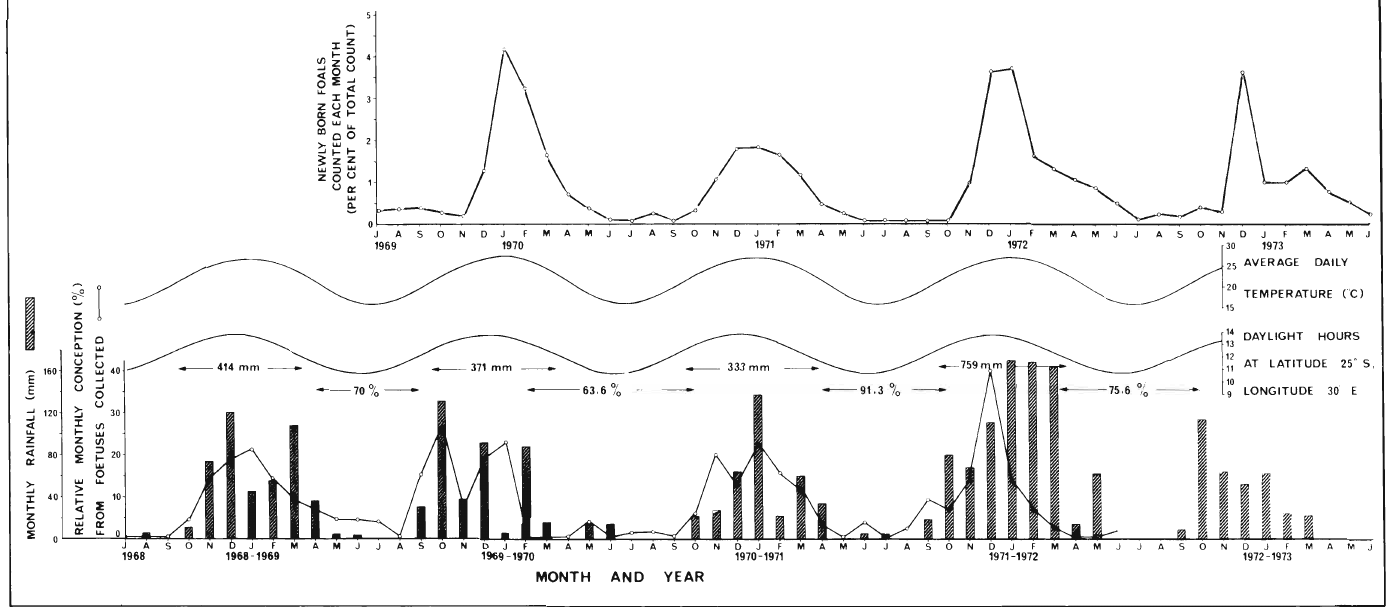
Fig. 6. The foaling season (upper graph) and mating season (lower graph) for zebra from the Central District of the Kruger National Park. Rainfall histograms as well as curves for average monthly daylight hours and average daily temperature are also included in the figure. Total summer precipitation (October to March) and conception rates for mares shot during the winter months of each year are illustrated above and between the conception